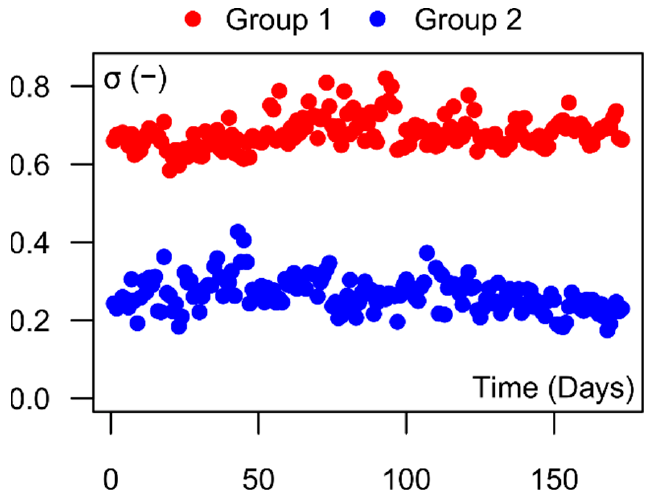
Figure 3. The daily standard deviation of the daily heat load pattern on the y-axis and the days of the heating season on the x-axis of user 4 belonging to group 2 and user 23 belonging to group 1.